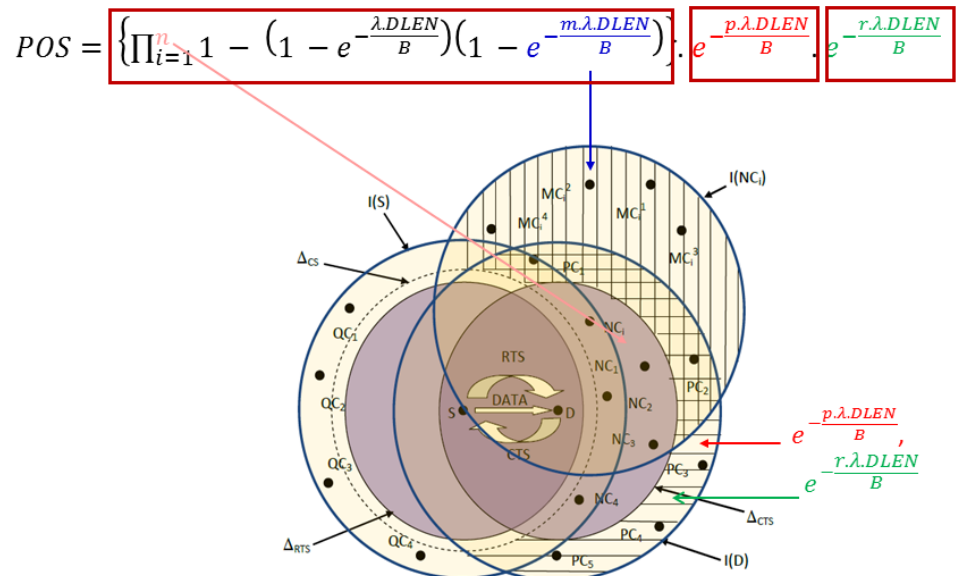
Figure 2. Illustration of the effects of RTS/CTS packets to nodes located near a test link from S to D